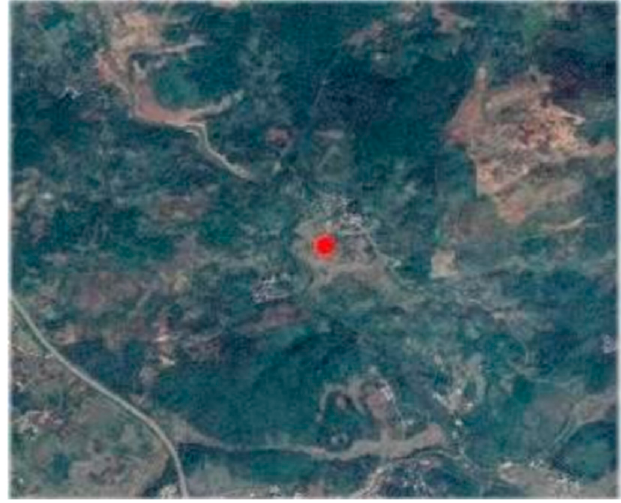
Figure 1. The study area location.